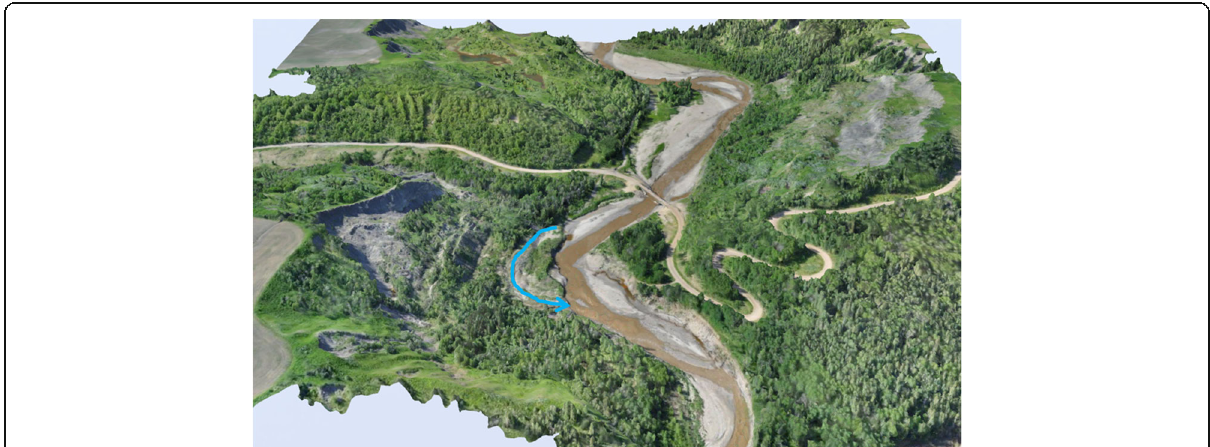
Fig. 10 Oblique aerial image mosaic of drone imagery, from June 2017, draped over a photogrammetrically generated digital elevation model depicting the Pouce Coupe River, and Landry Road and bridge (Source: Government of British Columbia; reproduced with permission). The 2013 landslide and dam are visible in the lower left. The approximate trace of the pre-landslide Pouce Coupe River channel is the blue line. The post-landslide